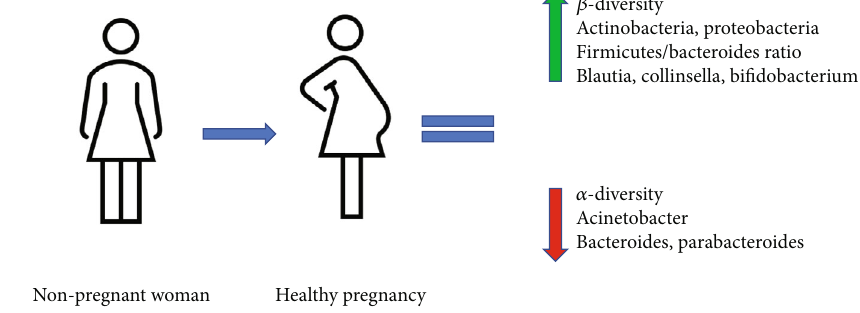
Figure 1: Di ff erences in the gut microbiota between a nonpregnant woman and healthy